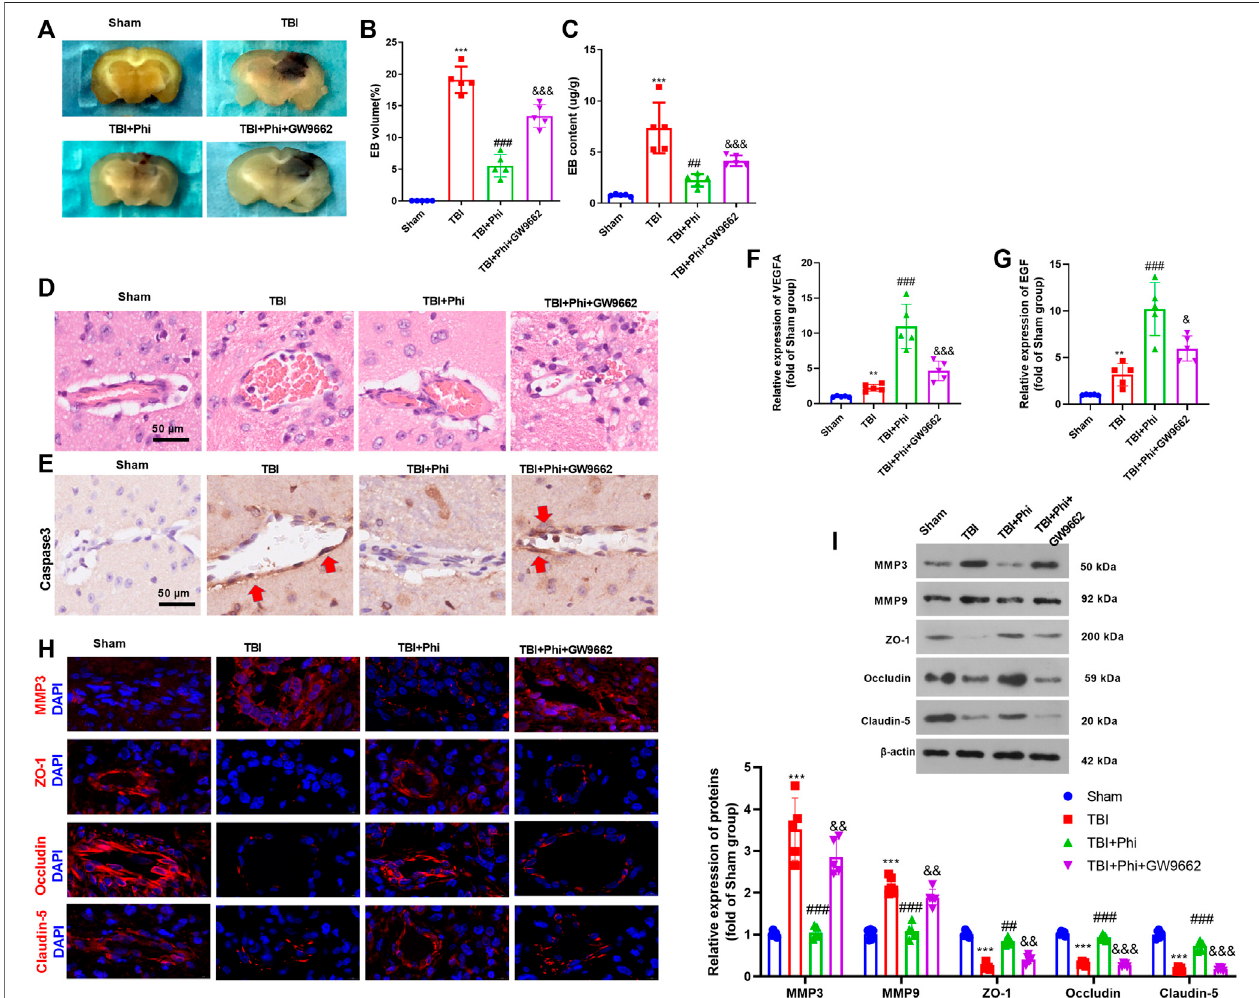
FIGURE 7 | Phi mitigated BBB damage on TBI mice. The mice subjected to TBI were treated with Phi (10 mg/kg) and/or GW9662 (1 μ mol/kg) 1 h before surgery and thereafter daily for seven days by intraperitoneal injection. The same volume ofthe solvent was given for the mice in the TBI or sham group. (A – C) BBB permeability wasinvestigatedbymeasuringtheextravasationofEvansbluedye( n (cid:1) 5). (D , E) HEandIHC(anti-caspase-3)wereusedtoobservetheintegrityofcerebralmicrovessels. (F , G) RT-PCRwasconducted tomeasureVEGFAandEGFinBMECsinthebrainlesions. (H) Tissueimmuno fl uorescencewasconductedtodetectMMP3,ZO-1, occludin, and claudin-5 inthe brain lesions. (I) Western blot wasused to detect the protein level ofMMP3, MMP9, ZO-1, occludin, and claudin-5 in the brainlesions ( n (cid:1) 5). The valuesare expressed asmean ± SD.** p < 0.01, *** p < 0.001 vs. thesham group; ## p < 0.01, ### p < 0.001vs. theTBIgroup; && p < 0.01, &&& p < 0.001 vs. the TBI+Phi group. n (cid:1)